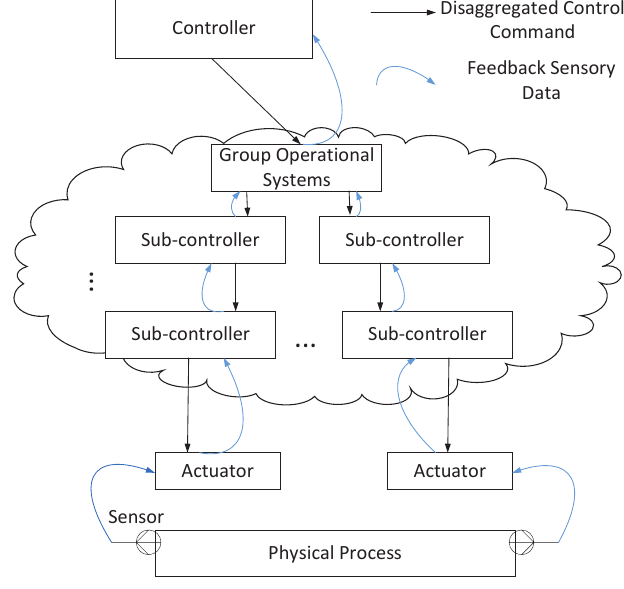
Figure 3. The structure of communication